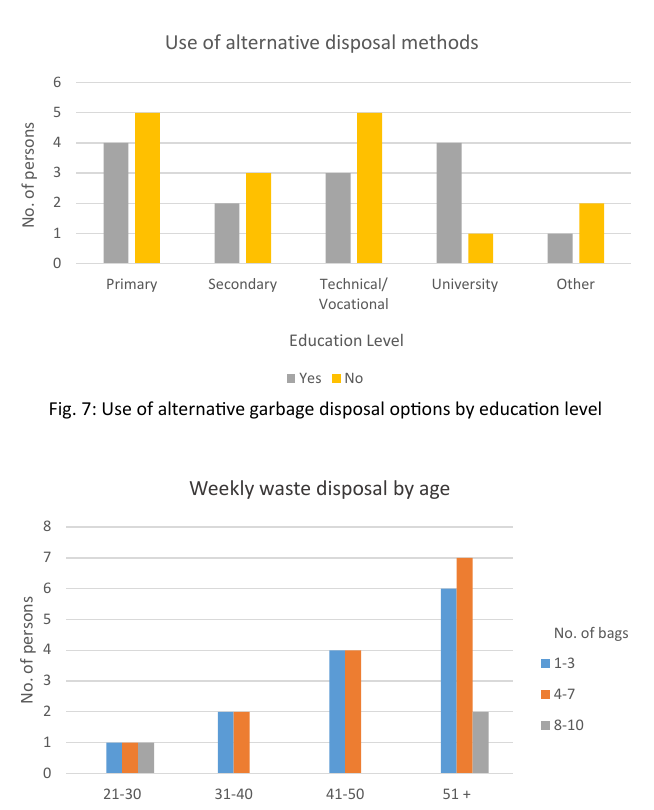
Fig. 8: Quantity of garbage disposed by age